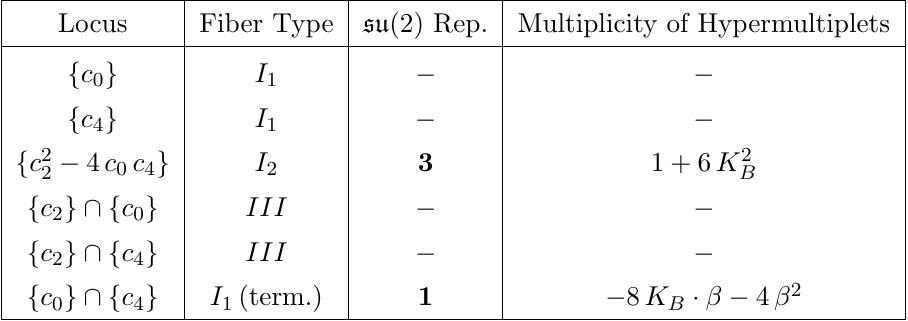
Table 4 . Singular (cid:12)bers and associated matter states of the blown-up Jacobian geometry ^ J ( Y b ). The singularities over f c 0 g \ f c 4 g are terminal and thus not